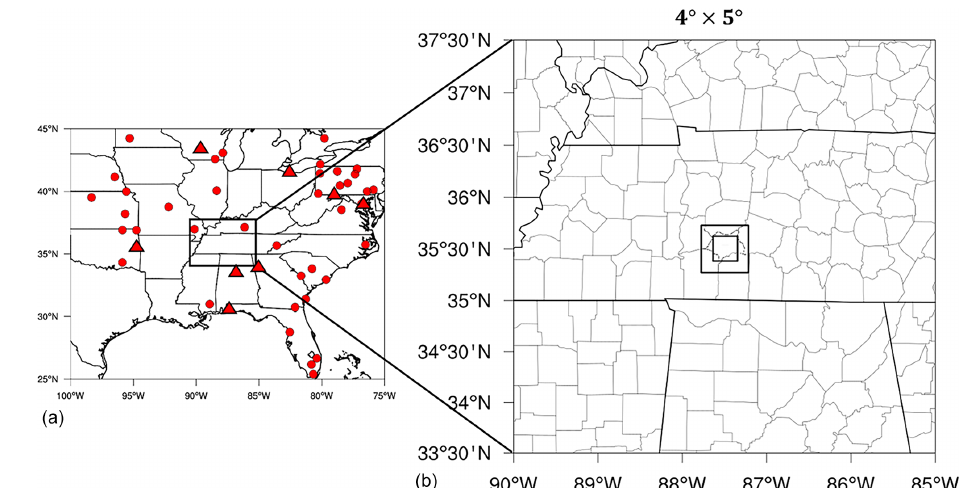
Figure 2. Model simulation domain: ( a ) black box represents a single grid of GEOS-Chem 4 ◦ × 5 ◦ simulation, red circles represent MDN sites and triangles represent AMNet sites within this domain; ( b ) comparison of one cell between a resolution of 4 ◦ × 5 ◦ , 50km × 50km, and 25km ×